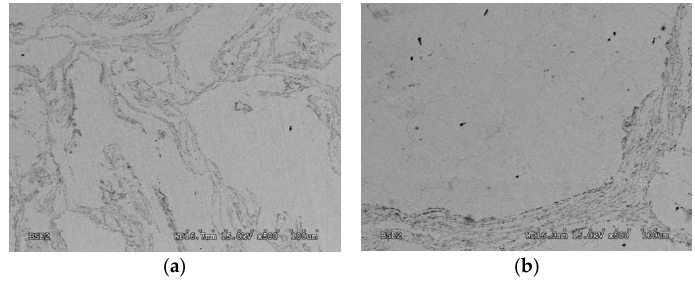
Figure 3. SEM micrographs of the sinters processed at ( a ) 900 °C, ( b ) 1100 °C.